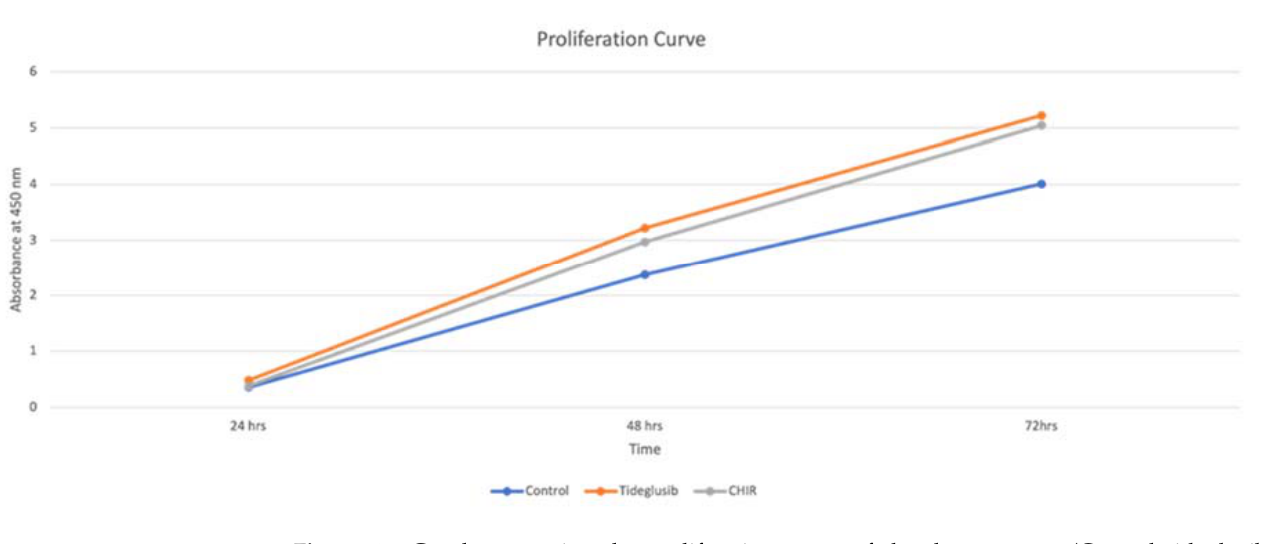
Figure 4. Graph presenting the proliferation curve of the three groups (Control–tideglusib– CHIR99021) over the period of 24, 48, and 72 h.